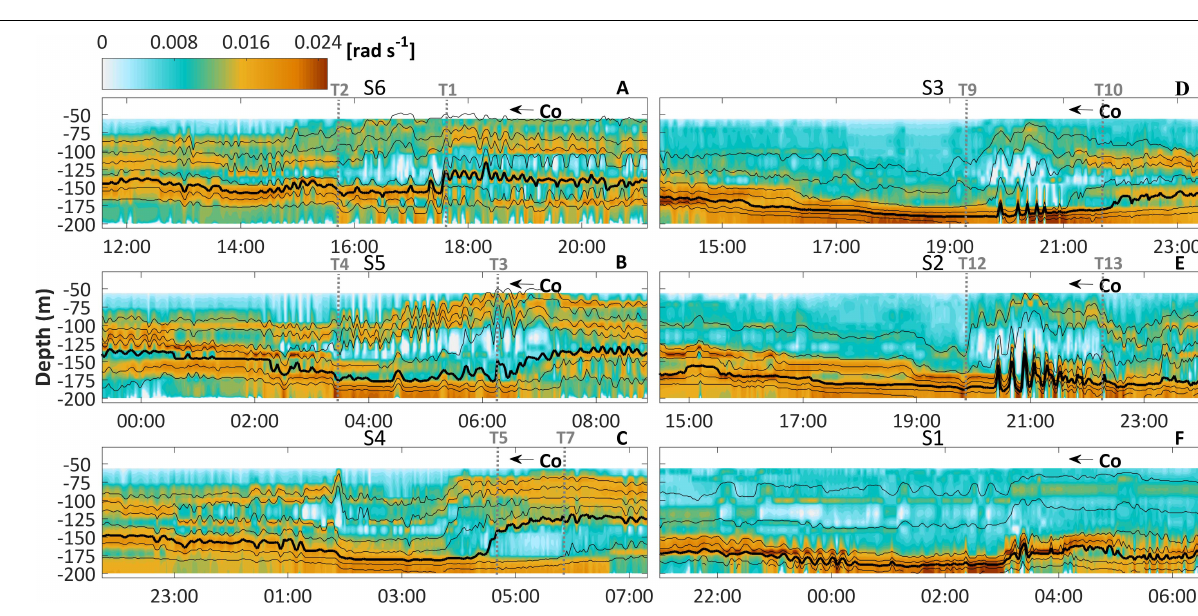
FIGURE 10 | As in Figure 6 , but for (A–F) rate of turbulent mixing field.